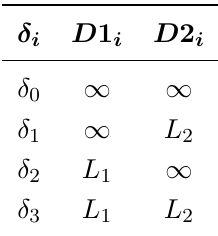
Table A1. Astigmatism compensation values of the long and short cavity arms for each stability limit, δ i